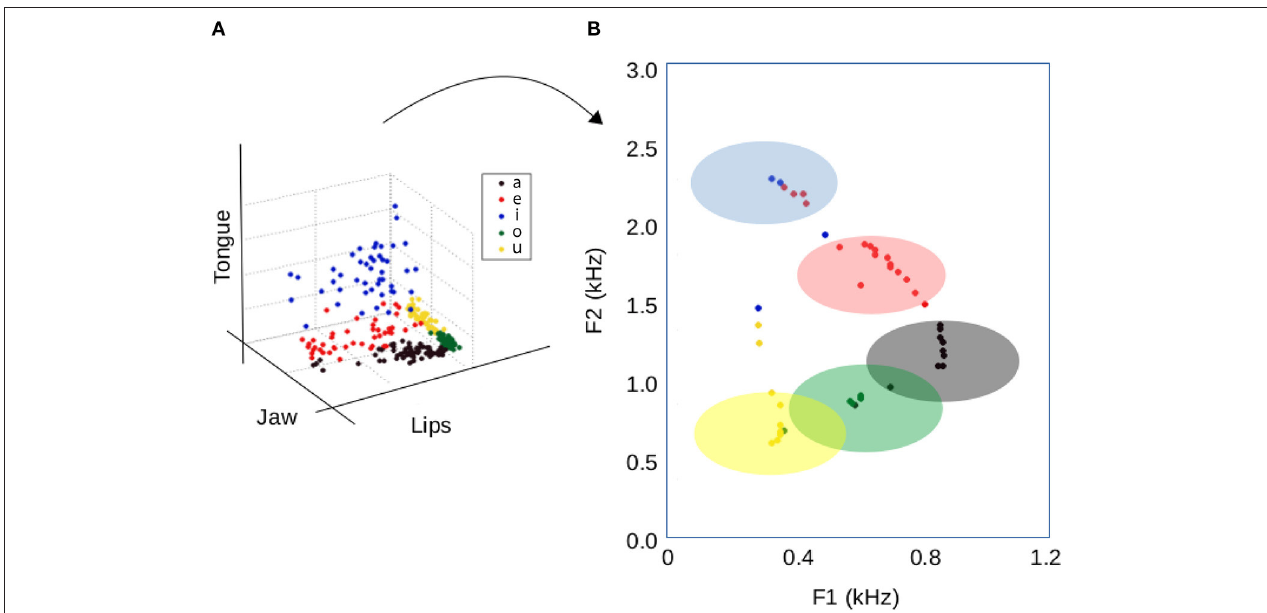
FIGURE 3 | Mapping the transducer signals into the formants space. The left panel shows the mean values h J , h T and h L of the transducer signals during the utterance of vowels by one participant. Each dot represents a vowel, colors stands for the vowel’s identity (/ a / is black, / e / red, / i / blue, / o / green, / u / yellow). The right panel maps each point in the transducers space to the formants space as described above, for ( m 1 , m 2 , m 3 ) = (300,300,900). The shaded regions represent the experimental variation in the formants F 1 and F 2 for Spanish vowels (Aronson et al.,